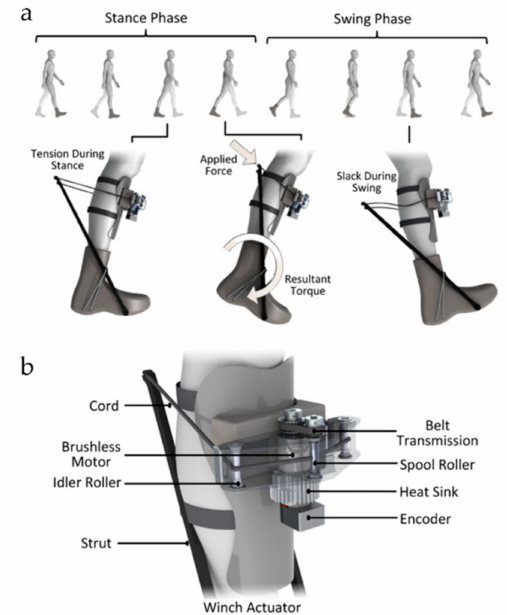
Figure 11. Autonomous powered leg exoskeleton. ( a ) Force applied during different phases of gait. ( b ) Device components [87] (Open